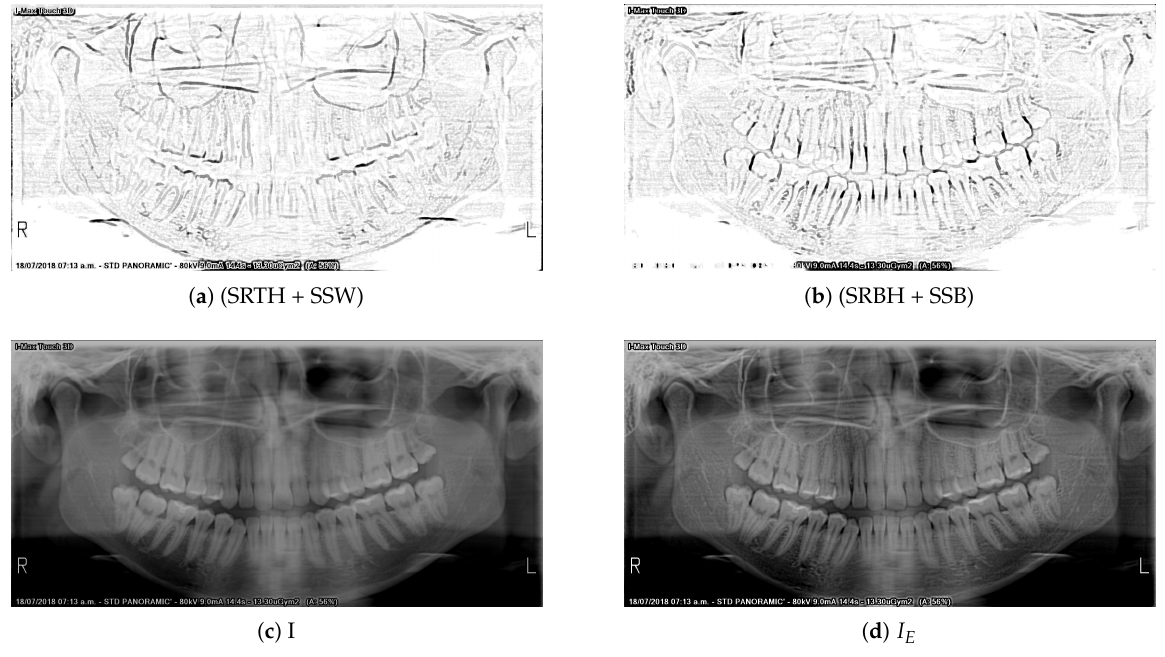
Figure 4. Enhancement of panoramic radiograph